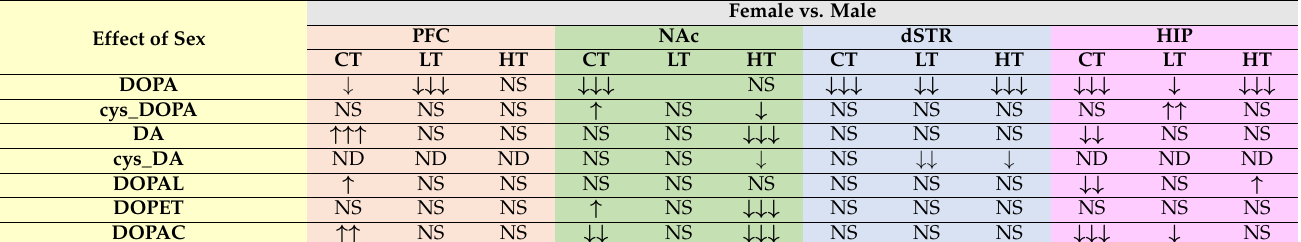
Table 1. Sex differences in dopamine and its metabolites in the